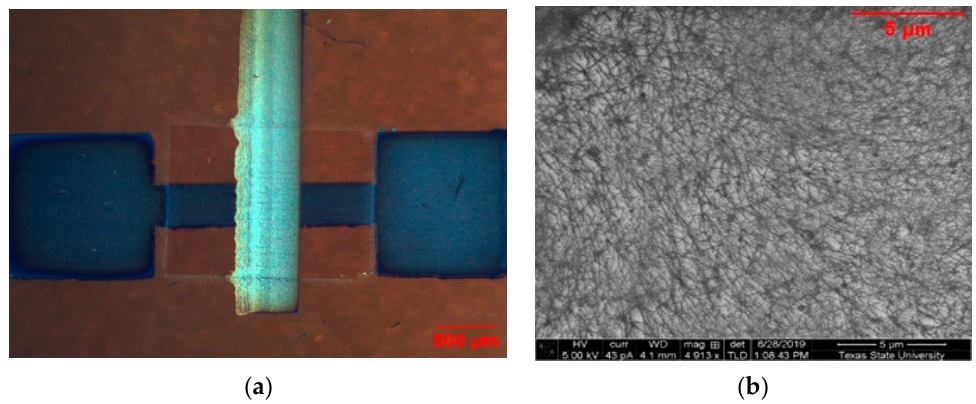
Figure 2. ( a ) Microscope image of printed device on Kapton ( b ); SEM image of the CNT network after 3 layers of printing.